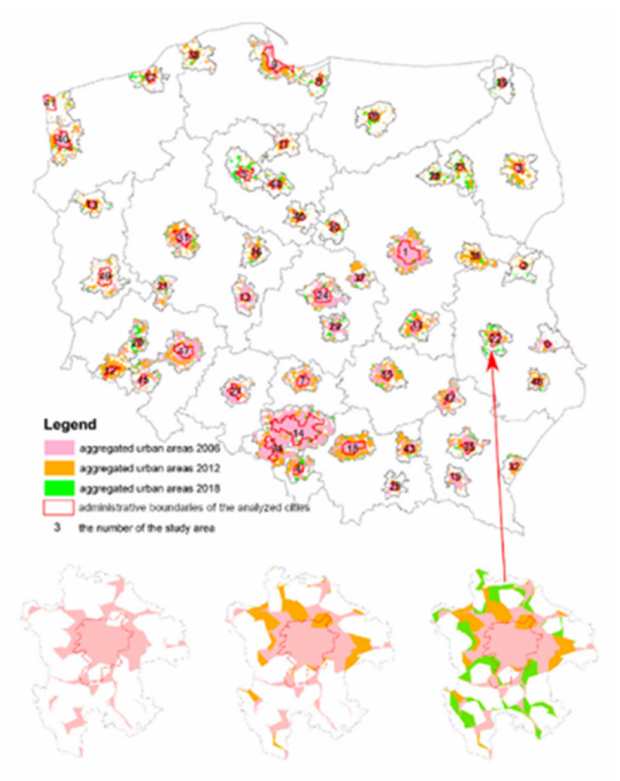
Figure 9. Aggregated urban areas. Source: